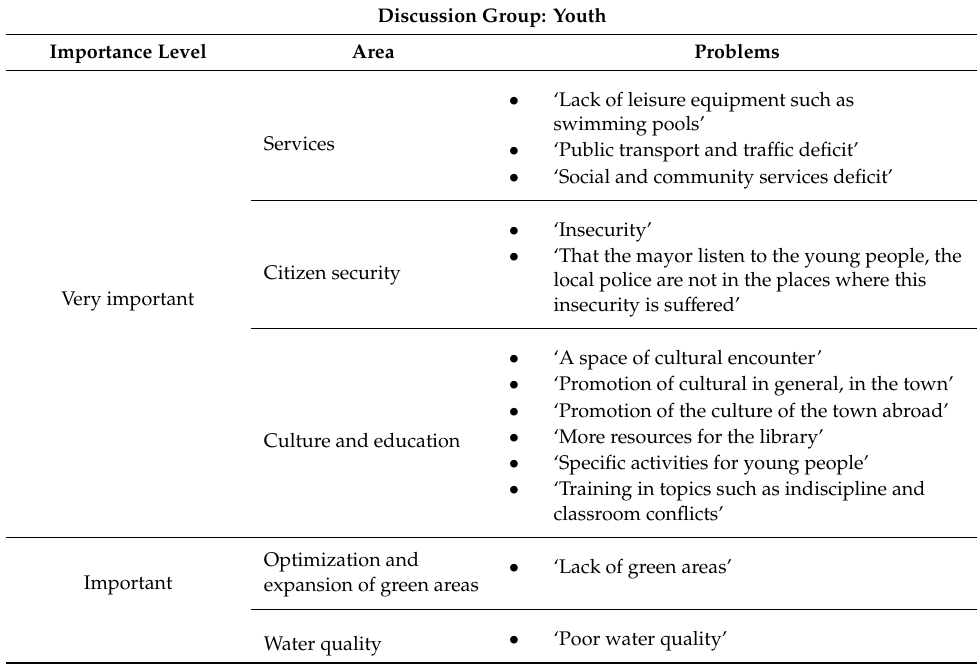
Table 12. Socio-environmental problems extracted from the discussion group